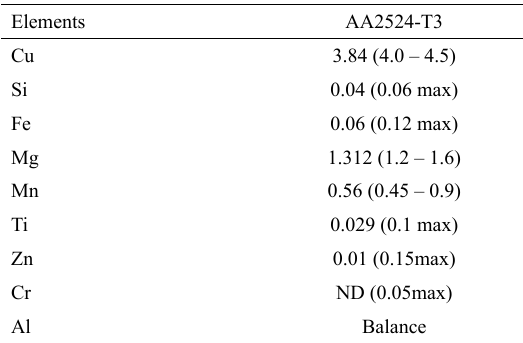
Table 1. Composition of the aluminium alloys (wt